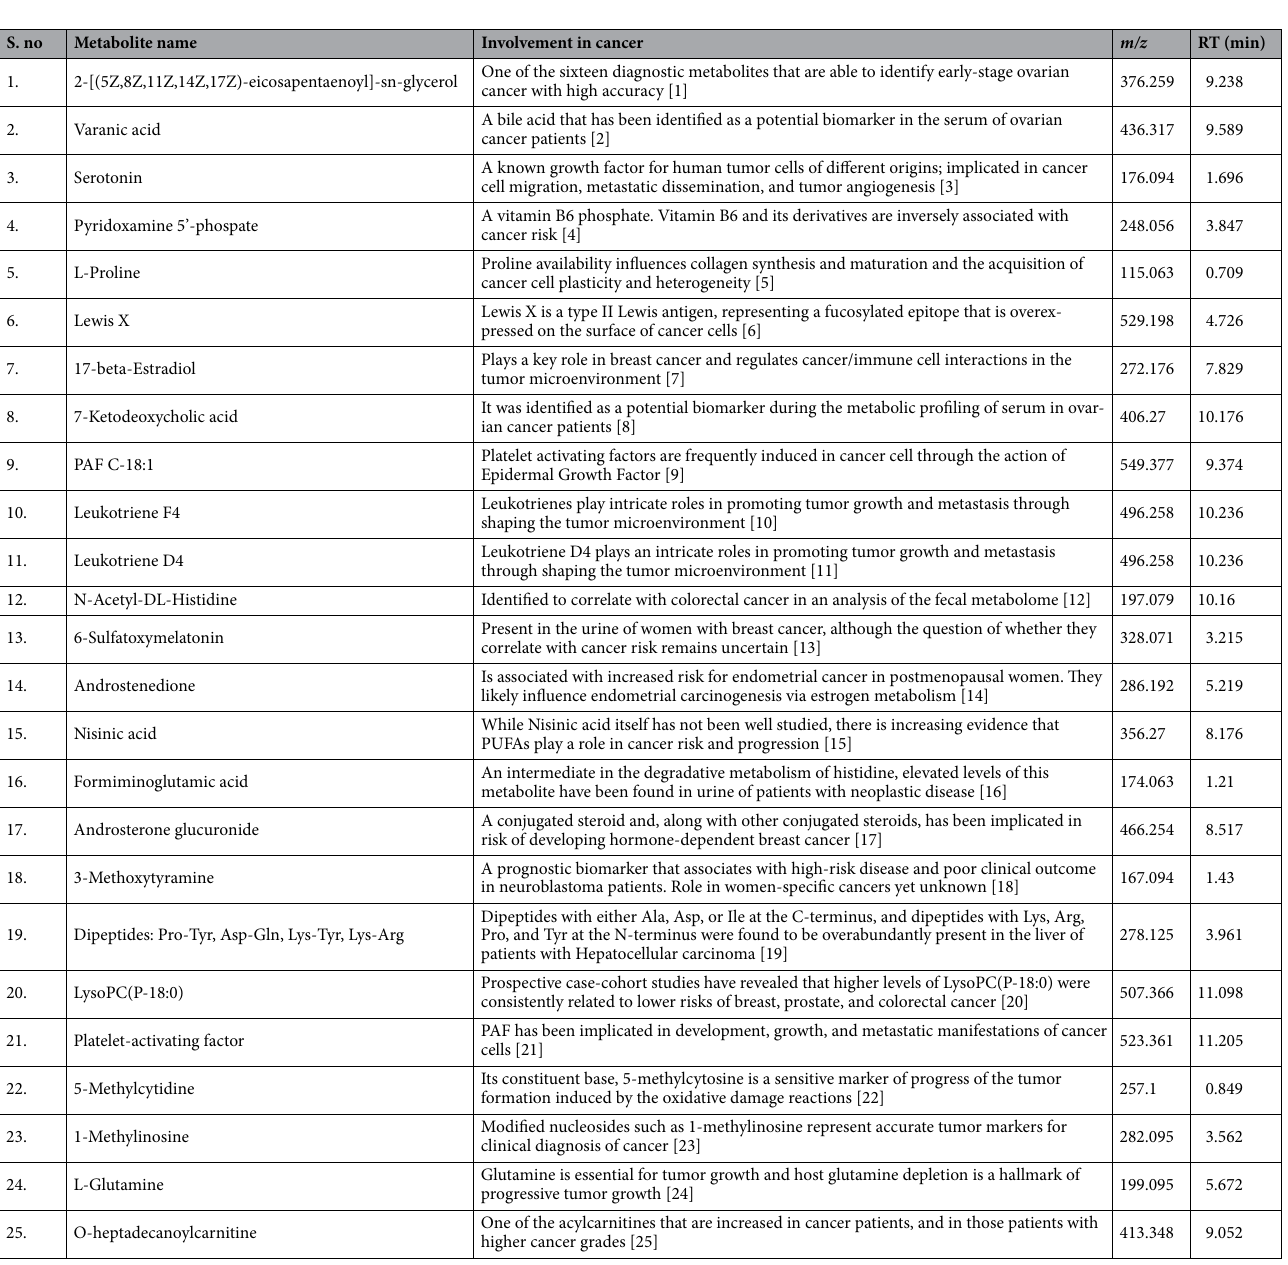
Table 2. List of select metabolites involved in the signature for distinguishing the BECO cancer group from normal controls. Literature references for the individual metabolites are listed in Supplementary Information. The mean m/z and retention time (RT) values for each metabolite are